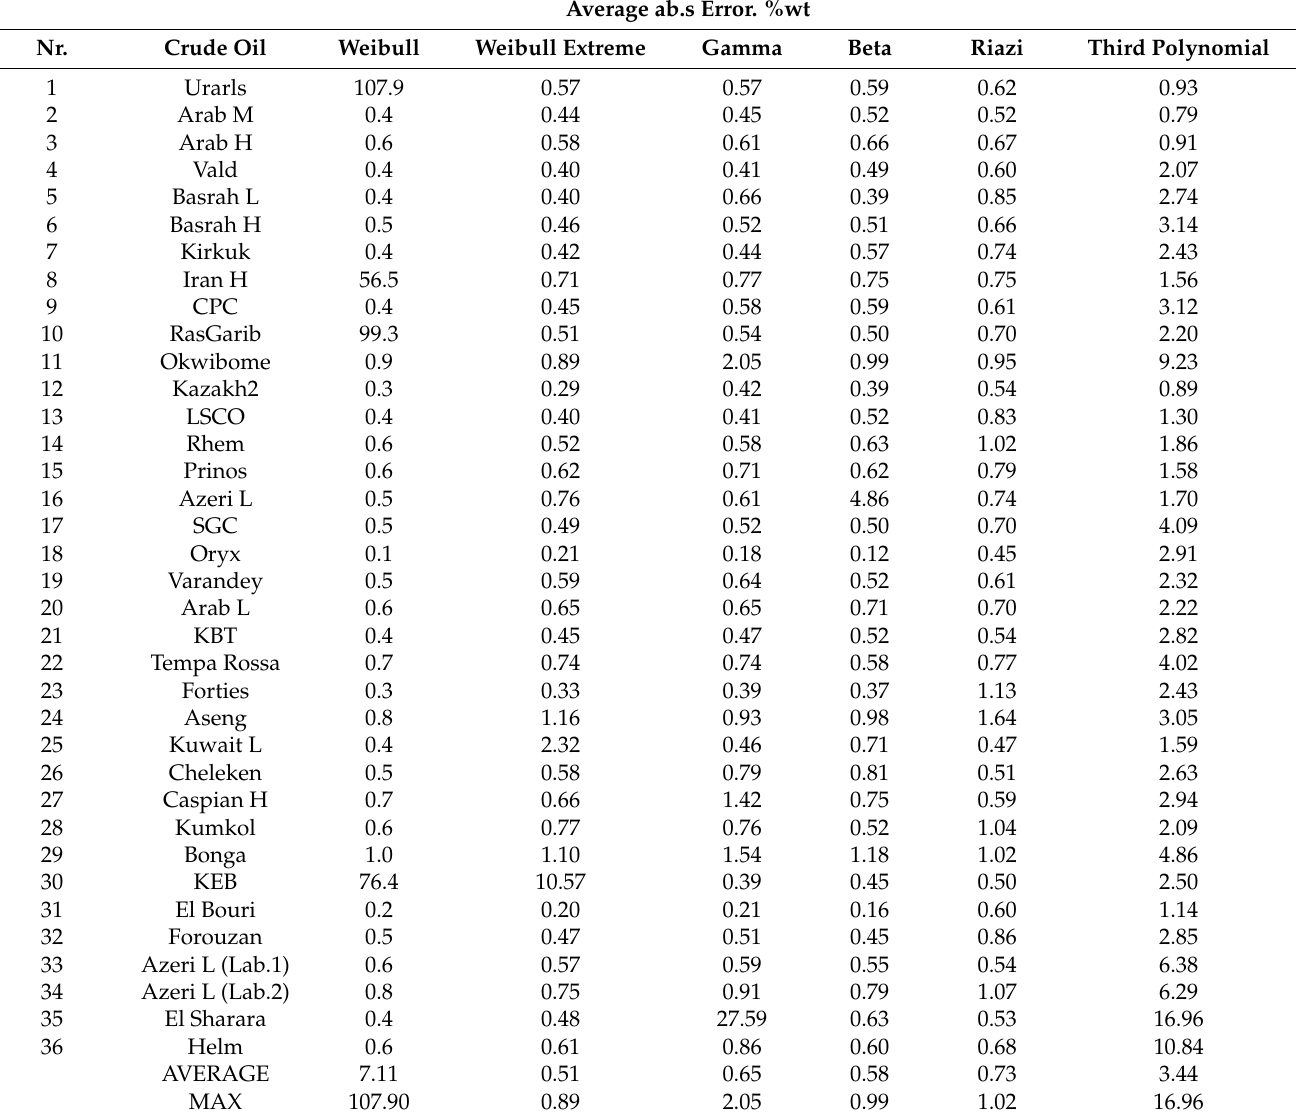
Table 3. Average absolute error of prediction of evaporate yield at different boiling points for the studied crude